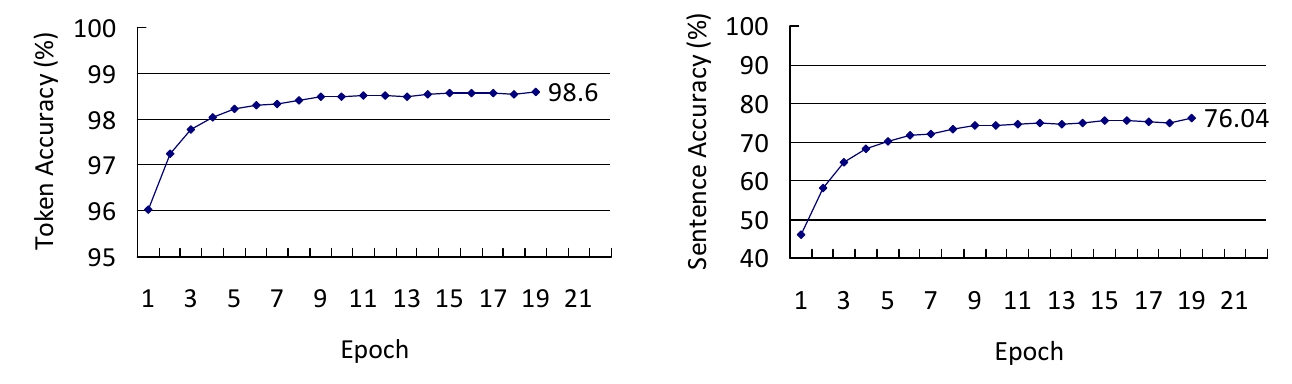
Figure 6. ( a ) The token accuracy of test set; ( b ) The sentence accuracy of test set. For comparison with other methods, four models are chosen as baseline systems as